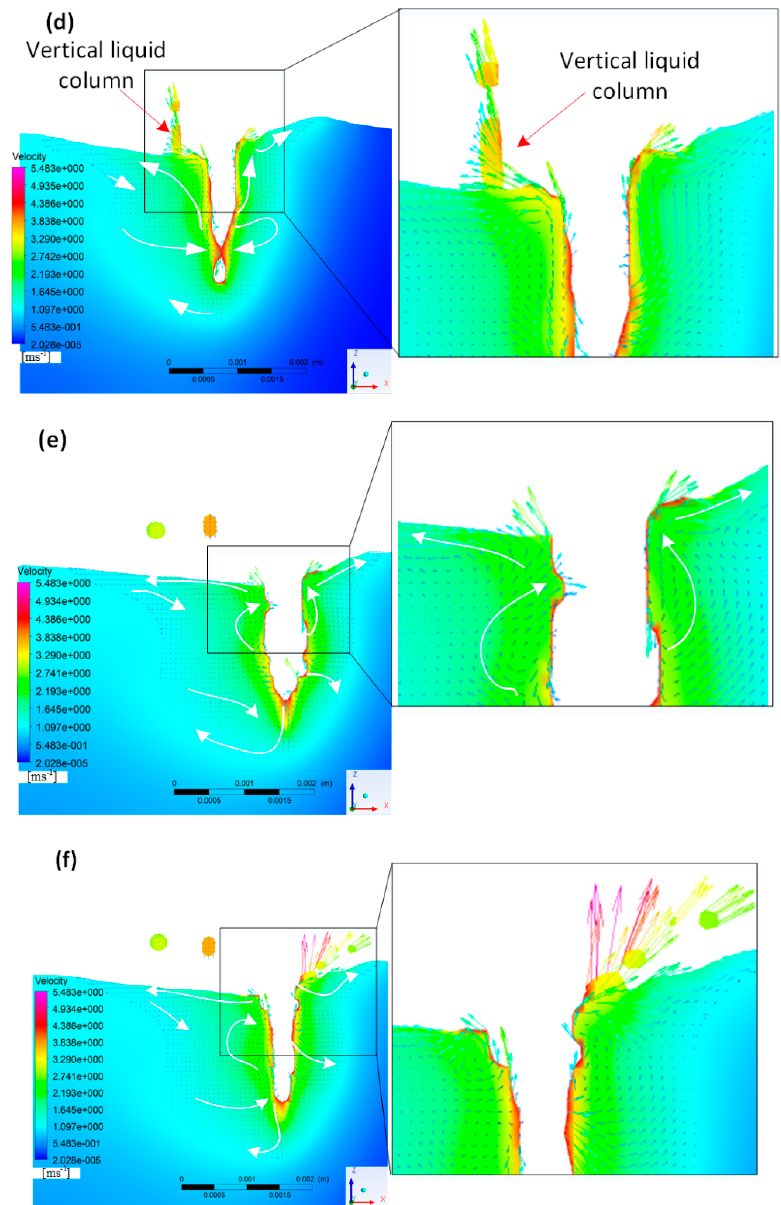
Figure 6. Flow field of the molten pool when the welding speed was 3 m/min: ( a ) t = 24 ms, ( b ) t = 25 ms, ( c ) t = 28.5 ms, ( d ) t = 28.8 ms, ( e ) t = 46.3 ms, ( f ) t = 46.8 ms.